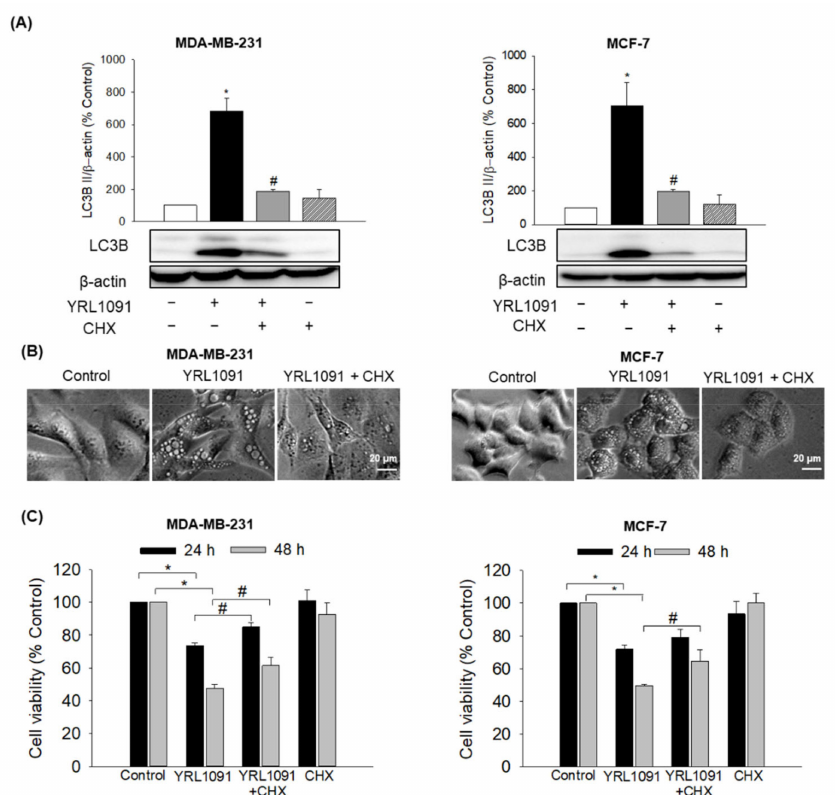
Figure 9. Requirement of protein synthesis in YRL1091-induced cytoplasmic vacuolization and cell death in MDA-MB-231 and MCF-7 cells. ( A – C ) Cells were treated with 30 µ M YRL1091 in the presence or absence of CHX (2 µ M, pretreatment for 2h) for 24 h. ( A ) Levels of LC3B were measured by western blotting. Each data point was calculated as the percentage of protein level in vehicle- treated control cells. Representative bands from at least three independent experiments were